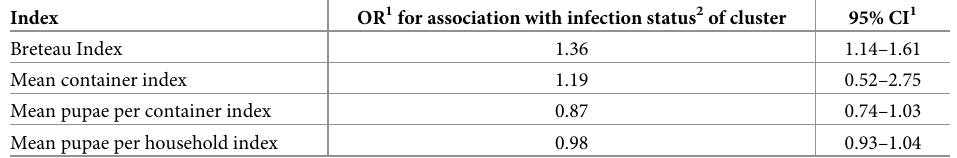
Table 2. Associations between vector indices and proportion of households with positive dengue serology at clus- ter level (150 clusters) from gamma regression.